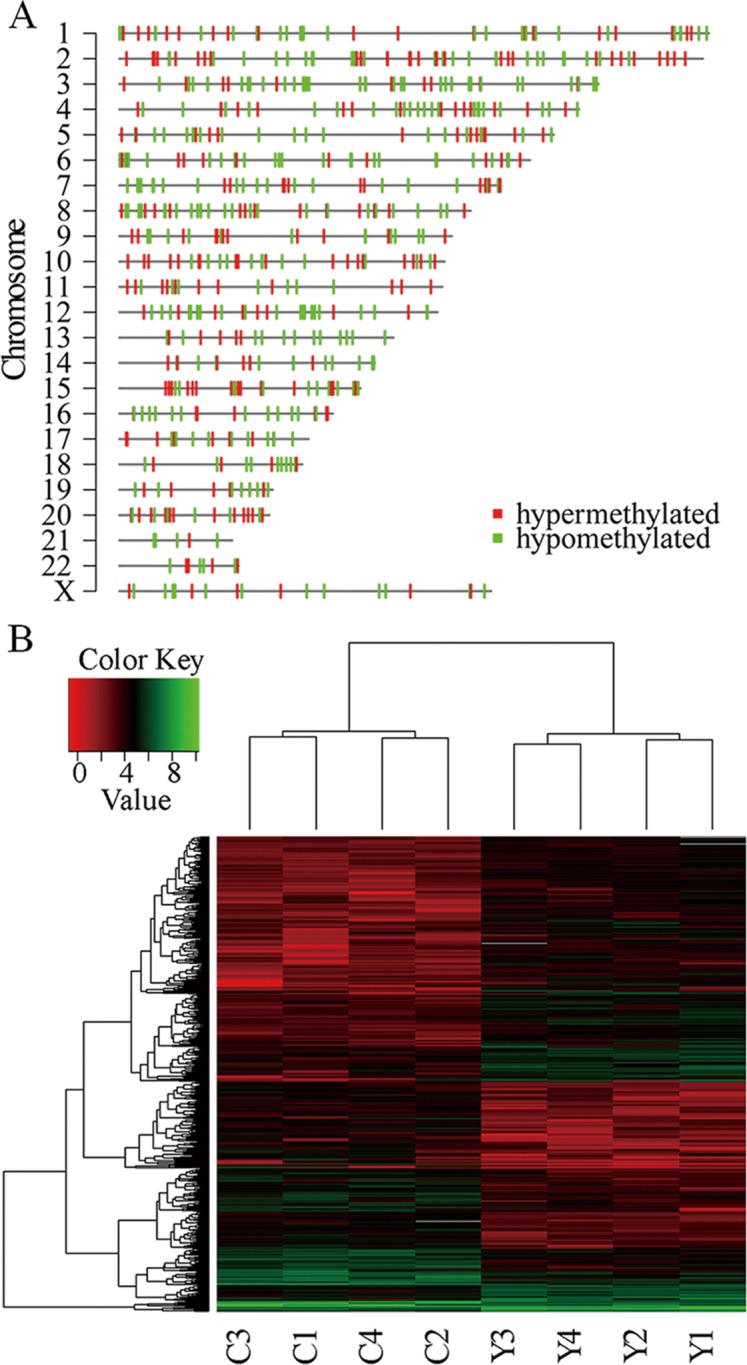
The identified differentially methylated regions (DMRs).(A) Vision of the distribution of DMRs on each chromosome. (B) Heatmap of all DMRs (The methylation value of each DMR was log2 transformed).